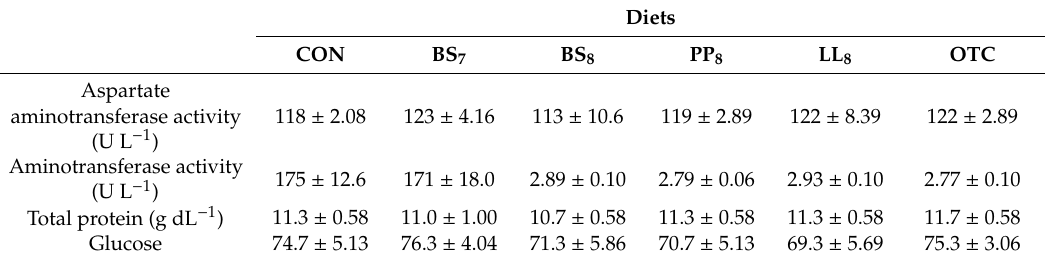
Table 7. Haematological analysis of juvenile whiteleg shrimp fed the different probiotics diets for 8 weeks 1 .